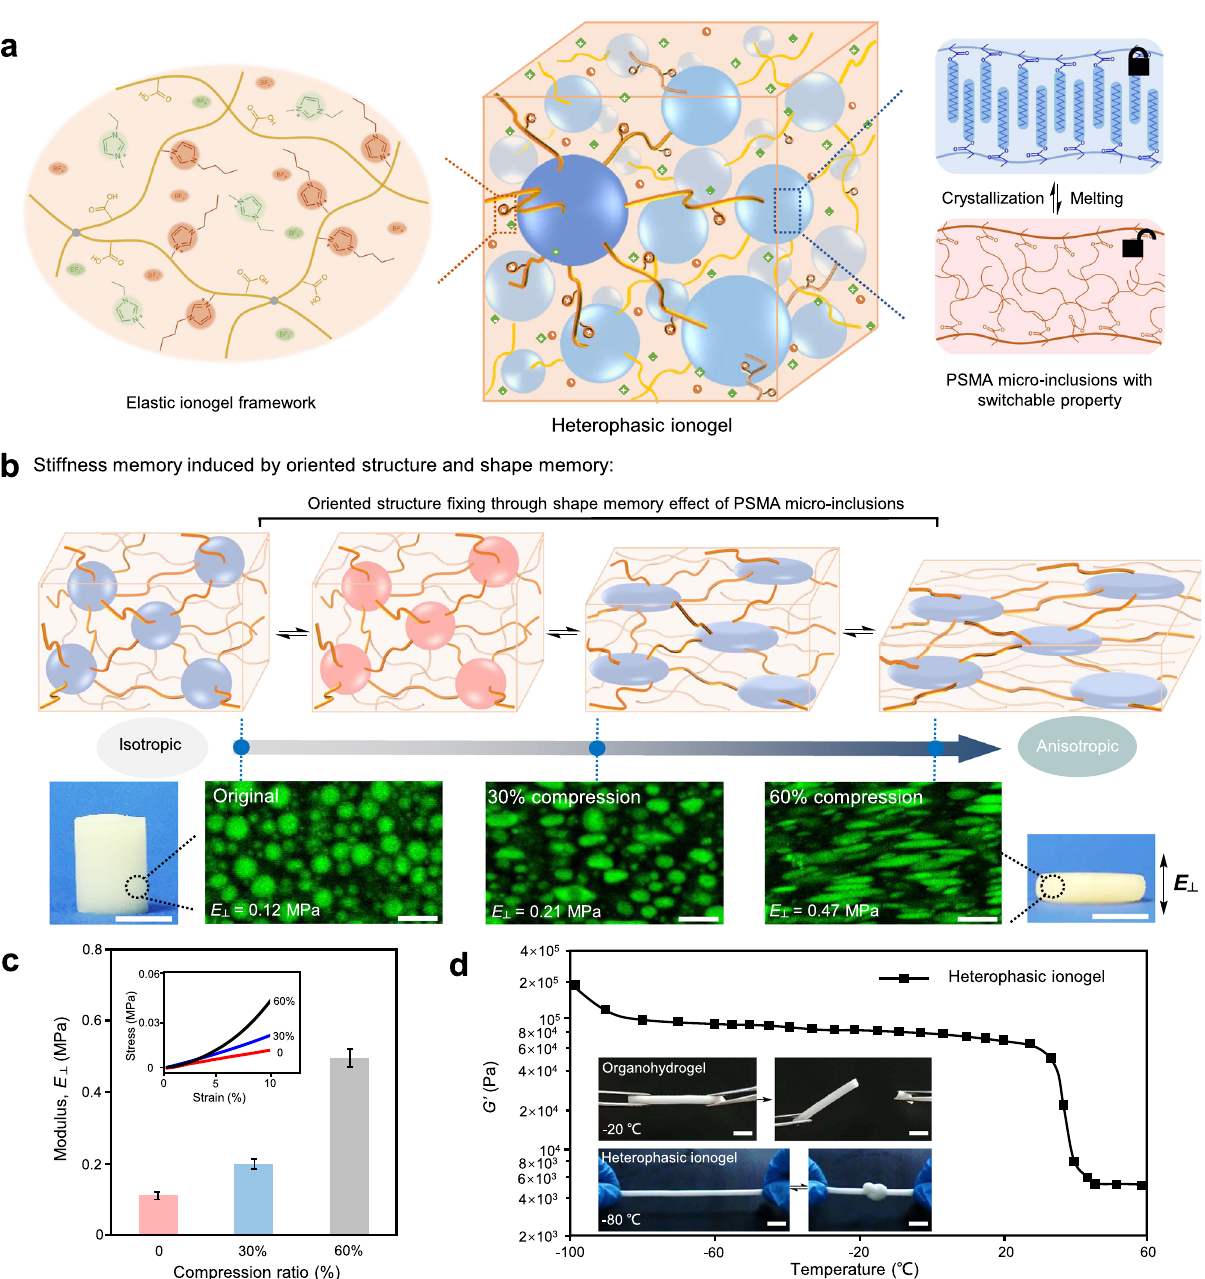
Fig. 1 Schematic illustration and stiffness memory of the heterophasic ionogels. a The heterophasic ionogels composed of elastic ionogel frameworks and switchable poly(stearyl methacrylate) (PSMA) micro-inclusions. b Stiffness memory effect of the ionogels by fi xing the oriented structure utilizing the shape memory effect of the PSMA micro-inclusions. Pictures showing the original and compressed ionogel samples, scale bar, 1 cm. The CLSM images indicated the structure change from isotropic to anisotropic of the heterophasic ionogels with different modulus, E ┴ (modulus perpendicular to the orientation direction), scale bar, 10 μ m. c Mechanical properties of heterophasic ionogels at different compression ratios. The enlarged fi gure clearly showed the enhanced stress of the compressed samples. The error bars represent 1 SD ( n = 3). d The storage moduli ( G ’ ) of the heterophasic ionogels in a wide temperature range. Inset pictures revealed the anti-freezing behavior of the heterophasic ionogel and the organohydrogel, scale bar, 1